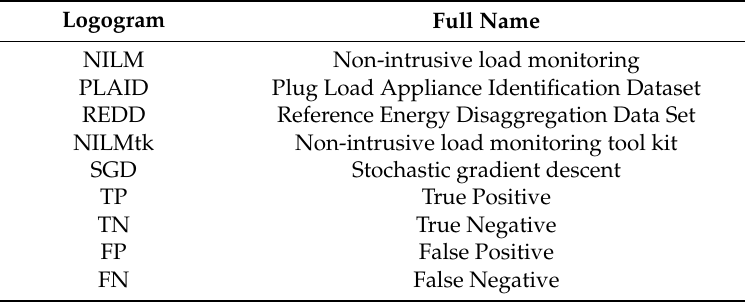
Table 1. A detailed overview of the